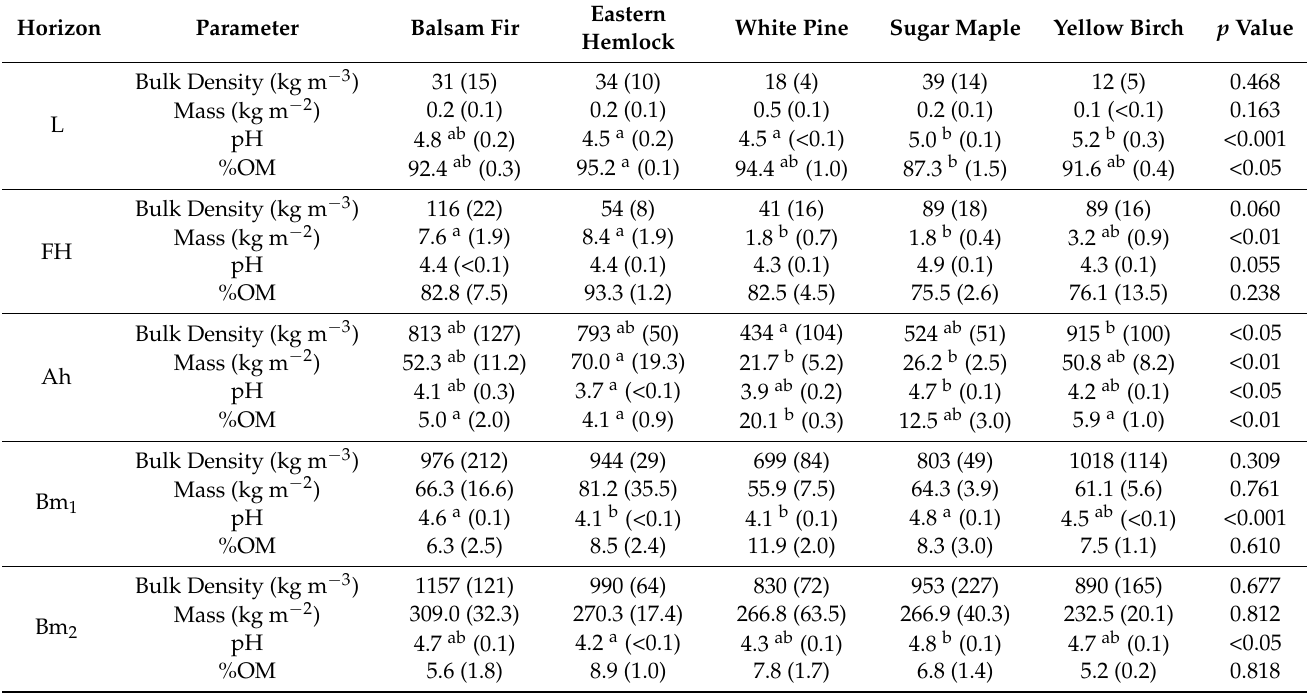
Table 2. Soil properties within the five stand types (mean ± S. E.). Different letters represent significant differences among stands. For BF, EH, and YB, n = 3. For SM and WP, n = 5. Horizon